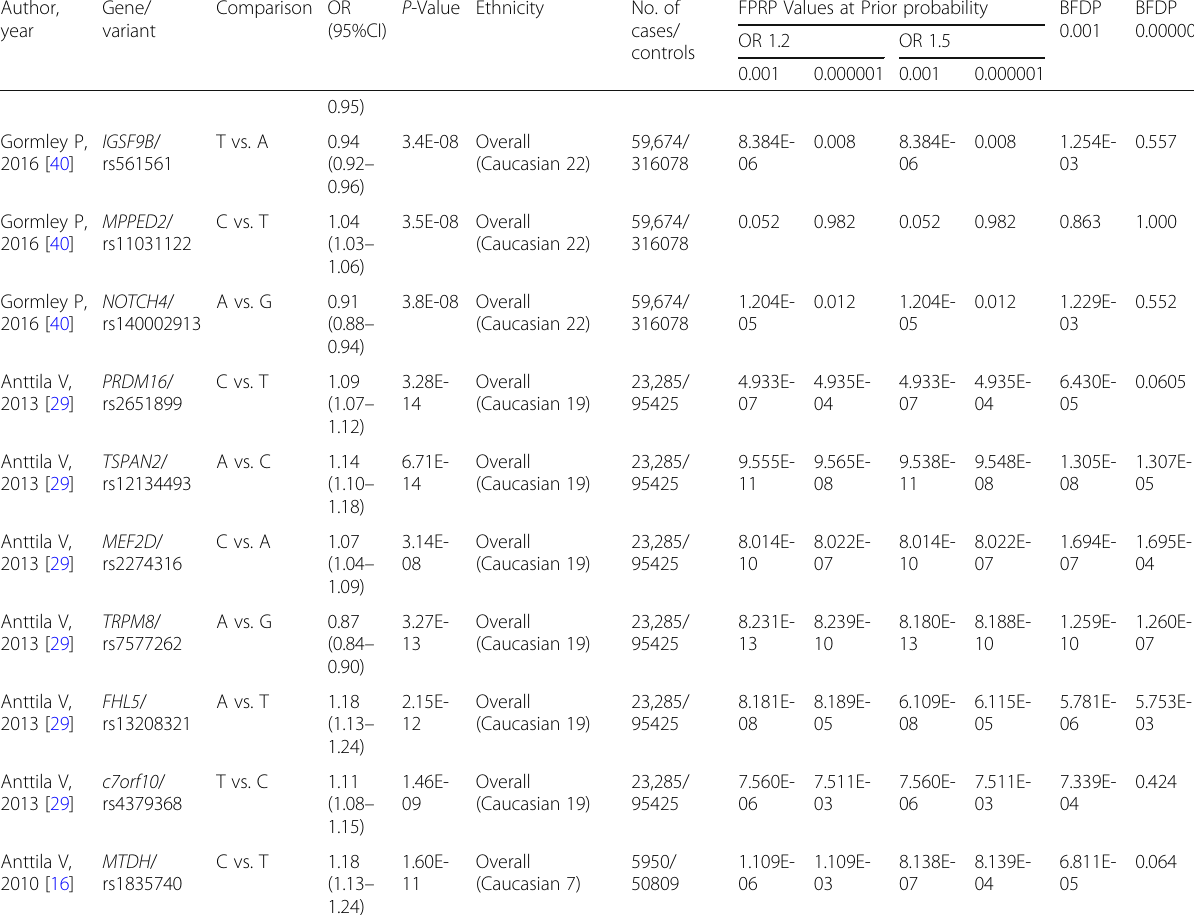
Table 2 Meta-analyses results of genetic variants with statistically significance ( P -value< 5*10 − 8 ) from GWAS